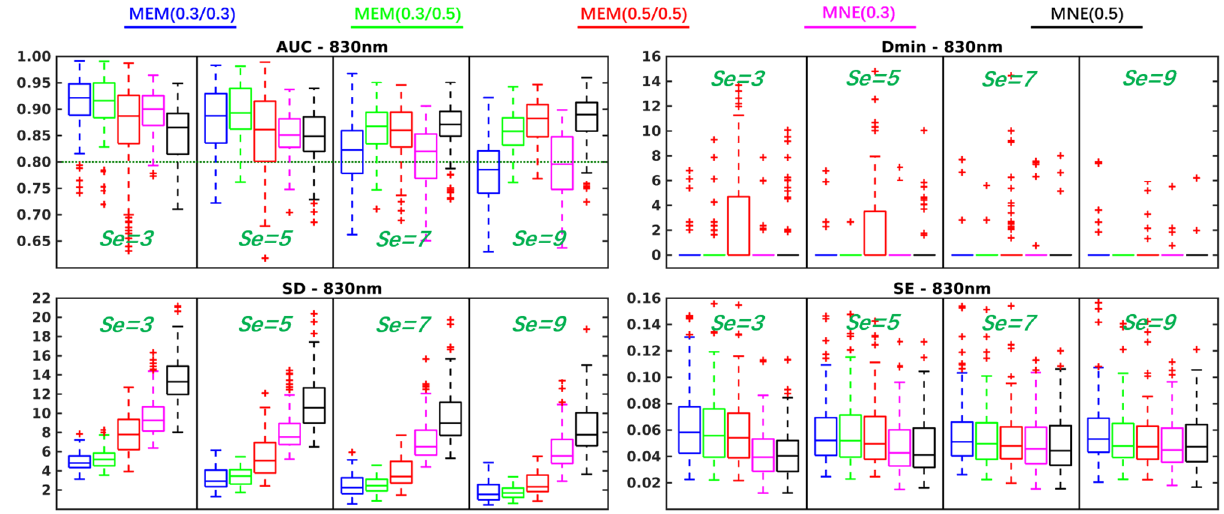
Figure 3. Evaluation of the performances of MEM and MNE using realistic simulations involving superficial seeds for different spatial extent ( Se = 3, 5, 7, 9 ). Boxplot representation of the distribution of four validation metrics for three depth weighted strategies of MEM and two depth weighted strategies of MNE, namely: MEM(0.3, 0.3) in blue, MEM(0.3, 0.5) in green, MEM(0.5, 0.5) in red, MNE(0.3) in magenta and MNE(0.5) in black. Results were obtained after DOT reconstruction of 830 nm (cid:31) OD . Figure created by MATLAB version (R2016a) https:// www. mathw orks. com/ produ cts/ matlab. html.